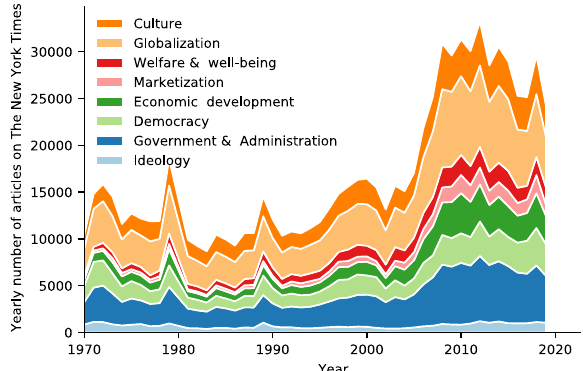
Fig. 2 Topic-speci fi c yearly volume of The New York Times articles with sentiment on China from 1970 to 2019. In each year we report in each topic the number of positive and negative articles while ignoring neutral/ irrelevant articles. The media have consistently high attention on reporting China government & administration, democracy, globalization, and culture. There are emerging interests on China ’ s economics, marketization, and welfare and well-being since 1990s. Note that the sum of the stacks does not equal to the total volume of articles about China, because each article may express sentiment in none or multiple